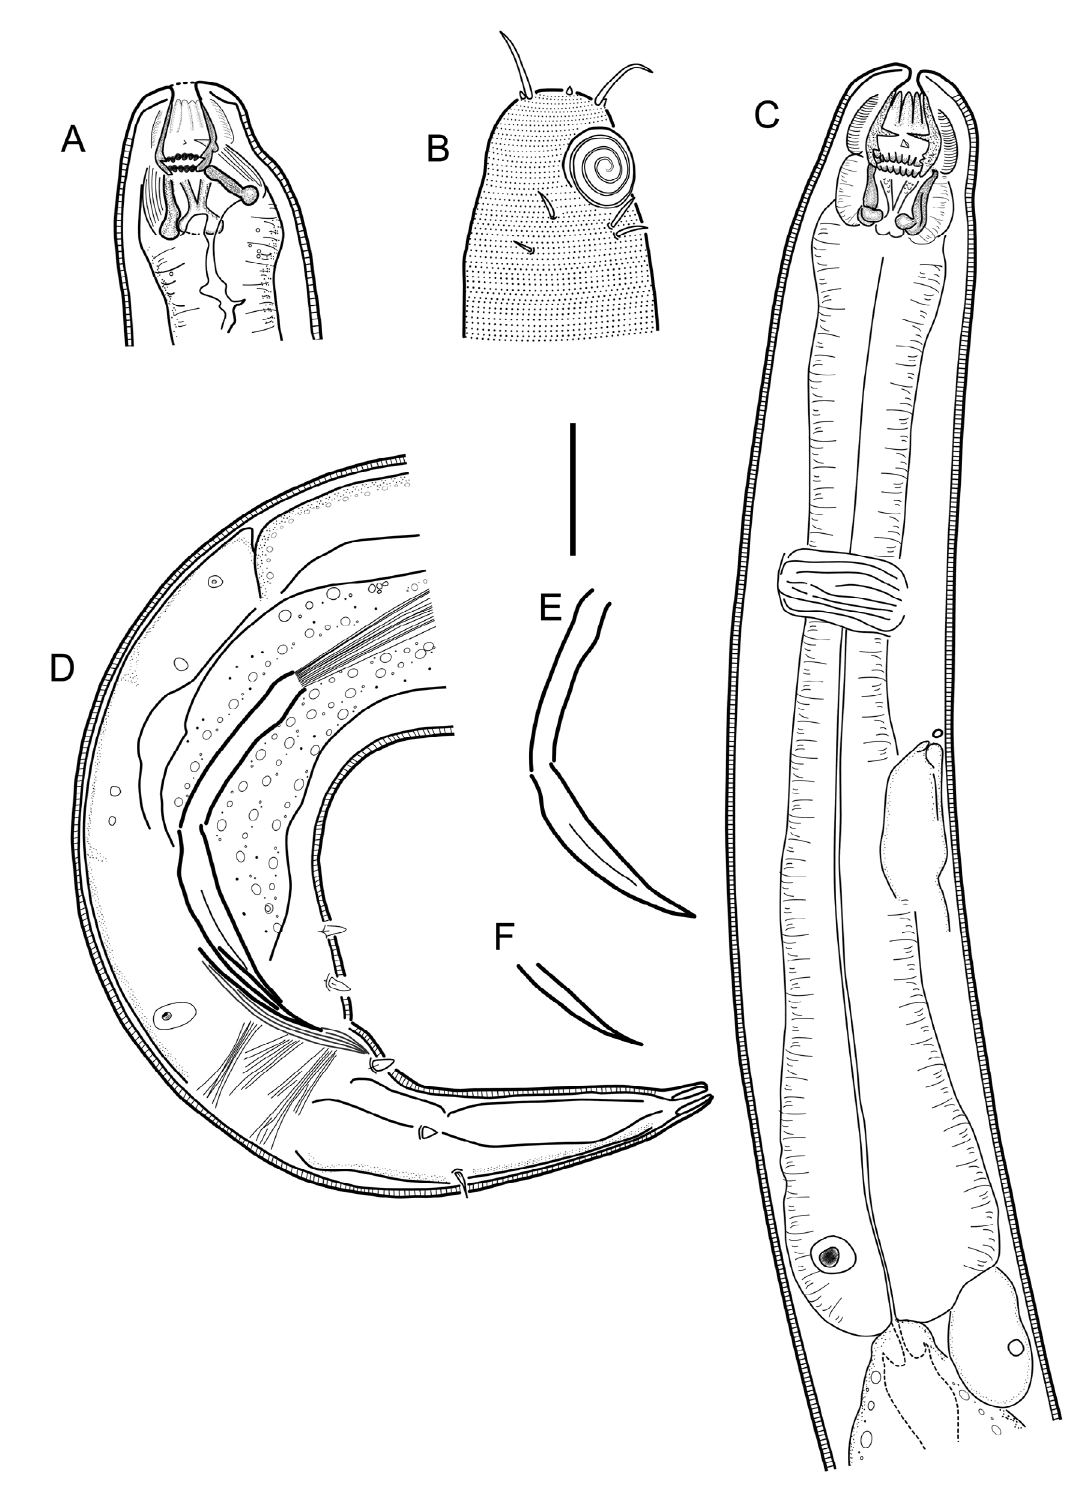
Fig. 8. Cobbionema acuminata sp. nov. A . Male paratype head region (ventral side to the right) (SMNH Type-9222). B . Surface view of male holotype head (ventral side to the right) (SMNH Type-9221). C . Anterior part of male holotype (ventral side to the right) (SMNH Type-9221). D . Caudal region of male holotype (SMNH Type-9221). E . Spicule. F . Crura. Scale bar = 20